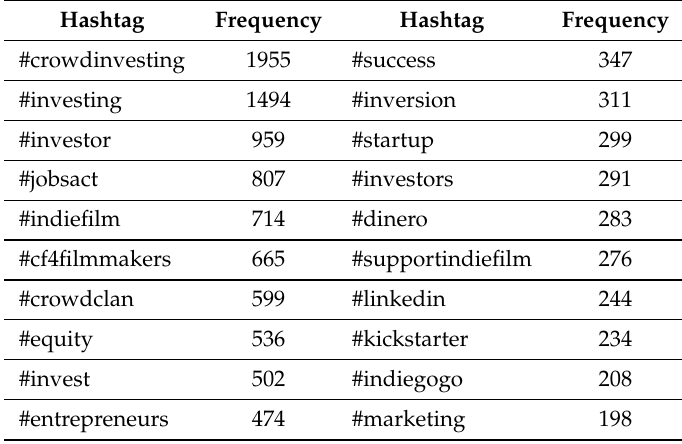
Table 7. Top 20 most recurring